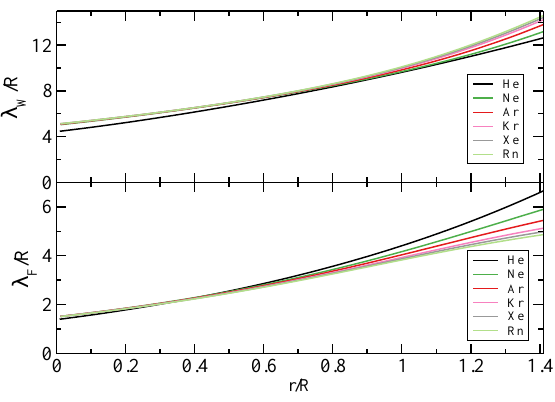
Figure 4. The scaled lengths λ F / R and λ W / R , versus the scaled distance r / R , for noble atoms (He-Rn).